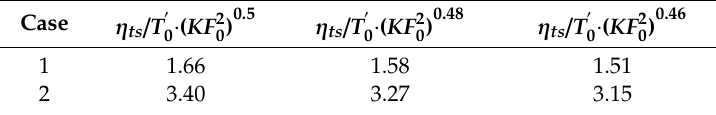
D (cid:48) · ( KF 2 ) for each 0 0